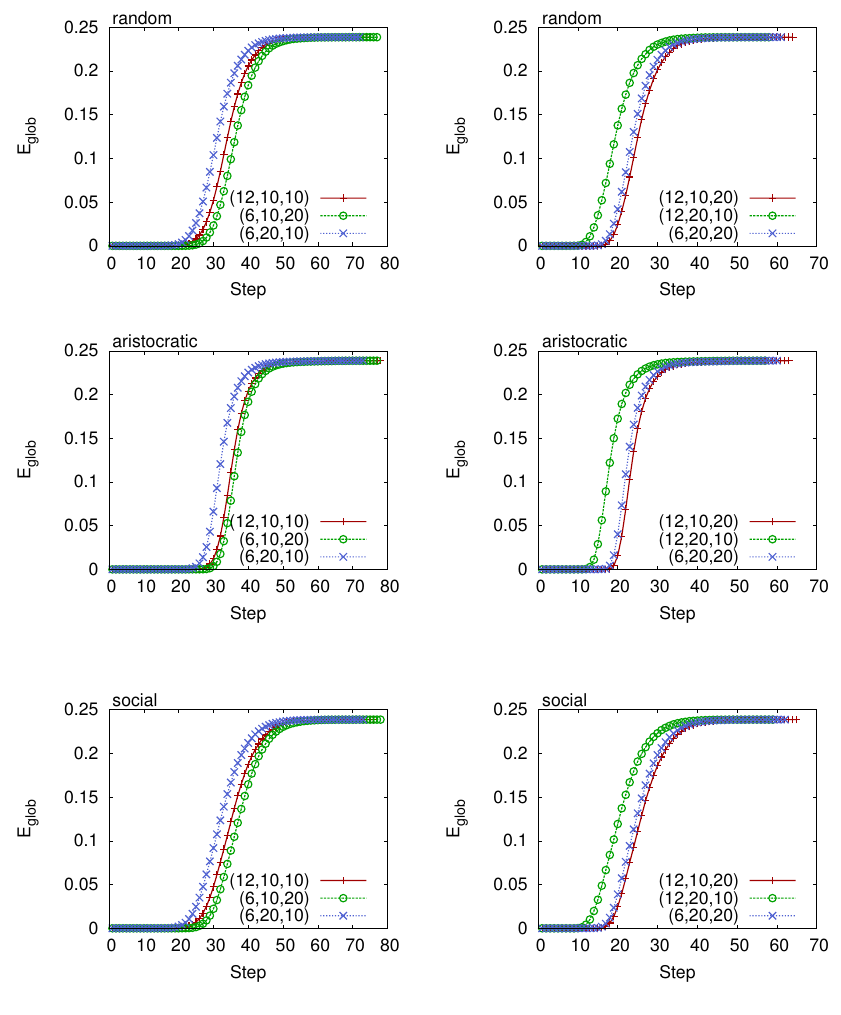
Figure 12. Accelerated analysis with mermaids, random, and aristocratic, social rules, preferential model , for the Communities social network with cost C s = 1200 ( left panels ) and C s = 2400 ( right panels ).